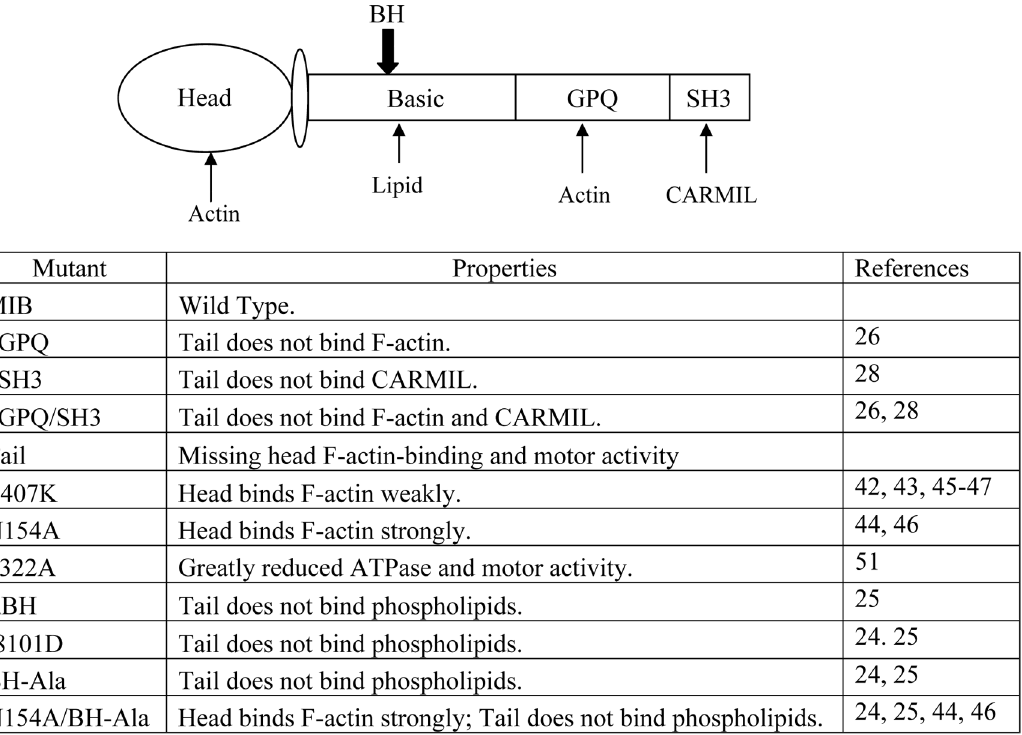
Figure 6. MIB mutants used in the current study.